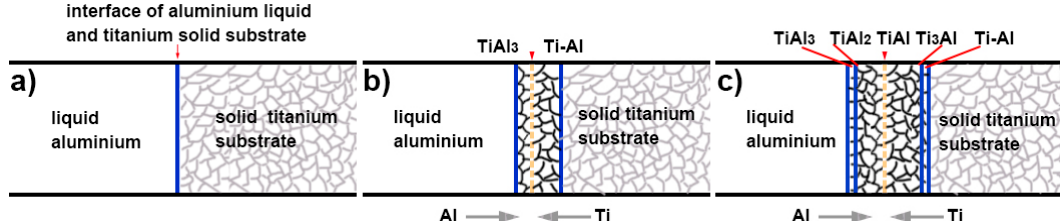
Figure 14. Schematic diagram of aluminium and titanium diffusion during the hot-dip aluminising process of the TA2 substrate. ( a ) wetting stage; ( b ) the initial stage of diffusion layer formation; ( c ) final stage of diffusion layer formation.